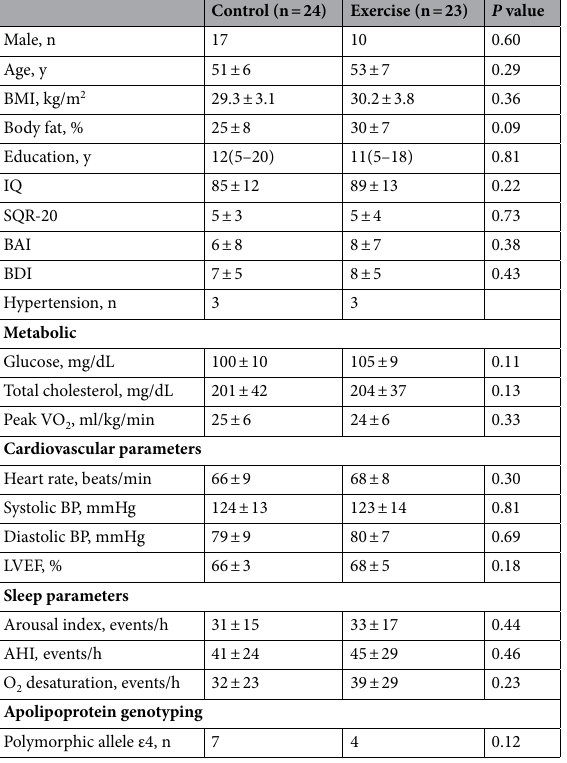
Table 1. Baseline characteristics of the population studied. Data are means ± SD. BMI body mass index; IQ estimated intelligence quotient; SQR-20 Self-Reporting Questionnaire; BAI Beck Anxiety Inventory score; BDI Beck Depression Inventory score; VO 2 oxygen uptake; LVEF left ventricle ejection fraction; BP blood pressure; AHI apnea–hypopnea index; O 2